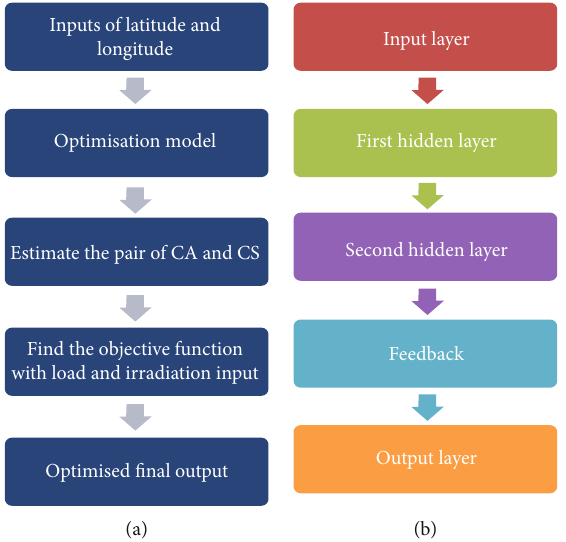
Figure 3: (a) Flowchart for estimating the sizing parameters based on MLP. (b) MLP block